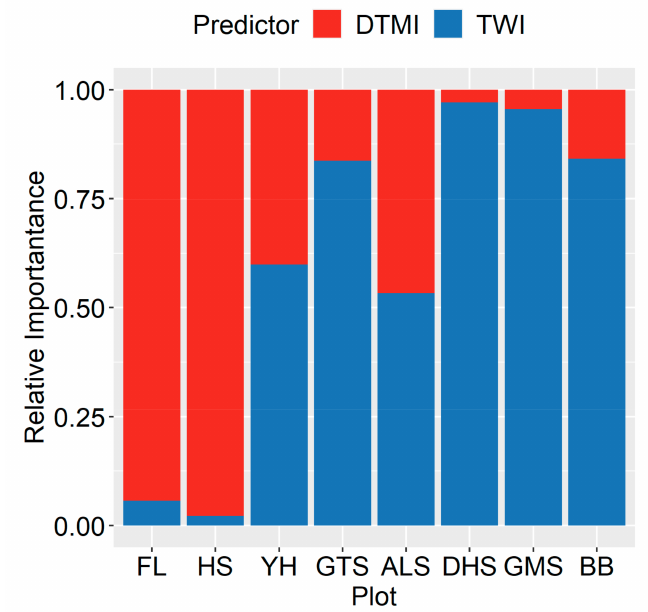
Figure 3. Result of the relative importance of two predictors (TWI and DTMI) in spatial simultaneous autoregressive error models (SARs). TWI is the blue part, and the red part represents the relative importance of DTMI in each plot. Results are arranged in descending latitude from left to